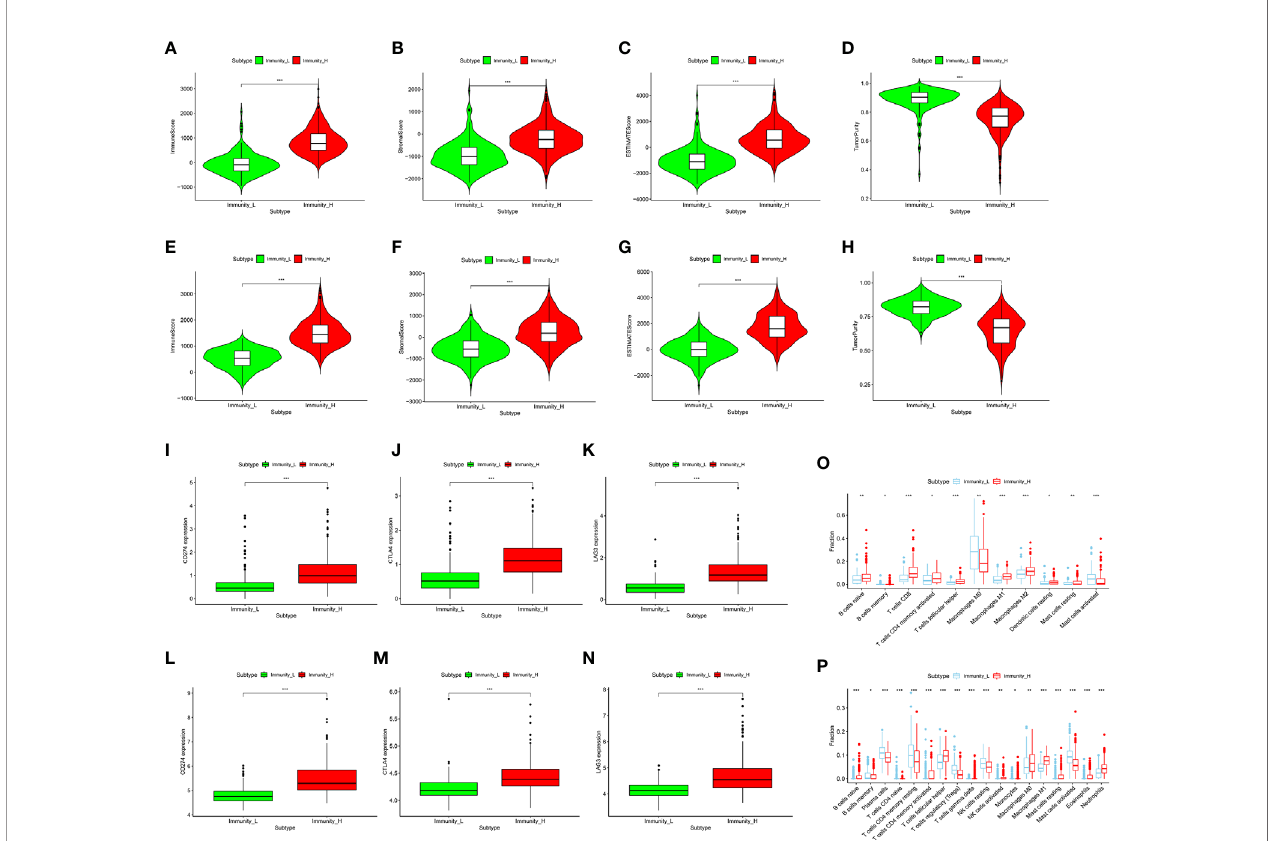
FIGURE 3 | Correlation of CRC Immune Subtypes With Tumor immune Microenvironment. (A – D) The violin plots showed that there were signi fi cant differences in ImmuneScore (A) , StromalScore (B) , ESTIMATE Score (C) , and TumorPurity (D) between the two subtypes in the TCGA cohort (both P < 0.001). (E – H) The same results were obtained in GEO GSE39582 cohort. (I – K) The expression of immune checkpoints, including CD274 (I) , CTLA-4 (J) , and LAG3 (K) , in Immunity_H (red) are all signi fi cantly higher than that in Immunity_L (green) in TCGA cohort (both P < 0.001). (L – N) The same results were also obtained in GEO GSE39582 cohort. (O, P) The boxplots showed the abundance difference of each immune cell between the Immunity_H (red) and the Immunity_L (blue) in TCGA (O) and GEO GSE39582 (P) cohorts. (* P < 0.05, ** P < 0.01, *** P <